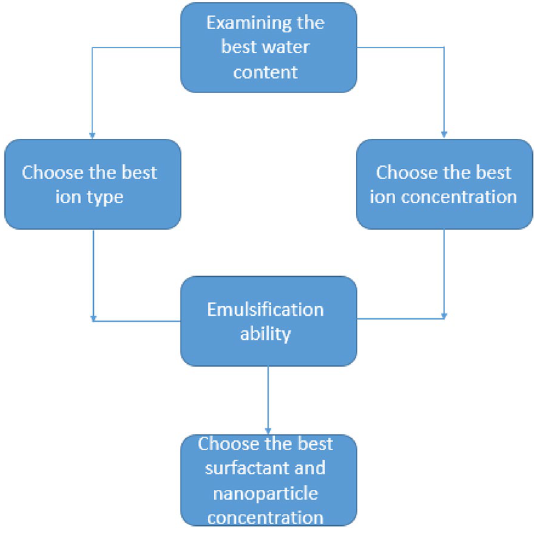
Figure 1. Flow work of research.